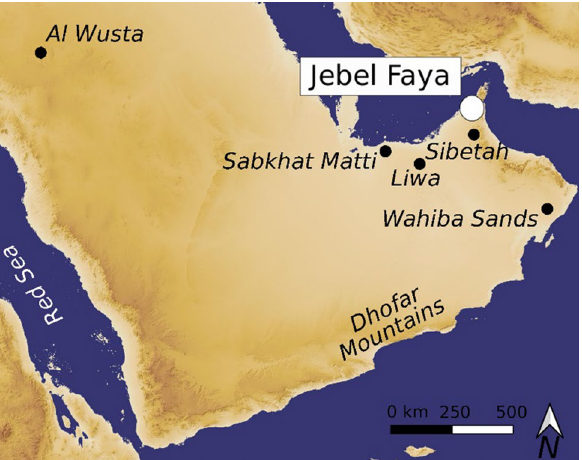
Figure 1. Map showing the location of Jebel Faya in Southeast Arabia and other sites and geographic regions mentioned in the text. Figure produced using QGIS 3.4. (https:// qgis. org) and Inkscape 1.0 (URL: https:// inksc ape.